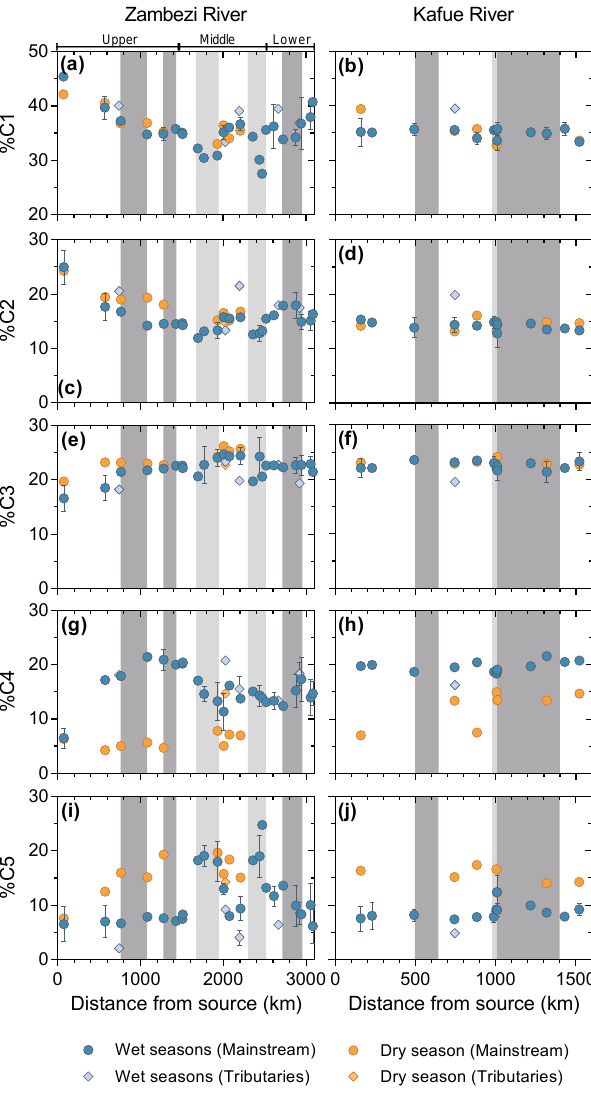
Figure 6. Longitudinal variations in the relative contribution of PARAFAC component along the Zambezi River (left panels) and the Kafue River (right panels) during the wet and the dry seasons. The diamonds represent samples taken from main tributaries up- stream of their confluence with